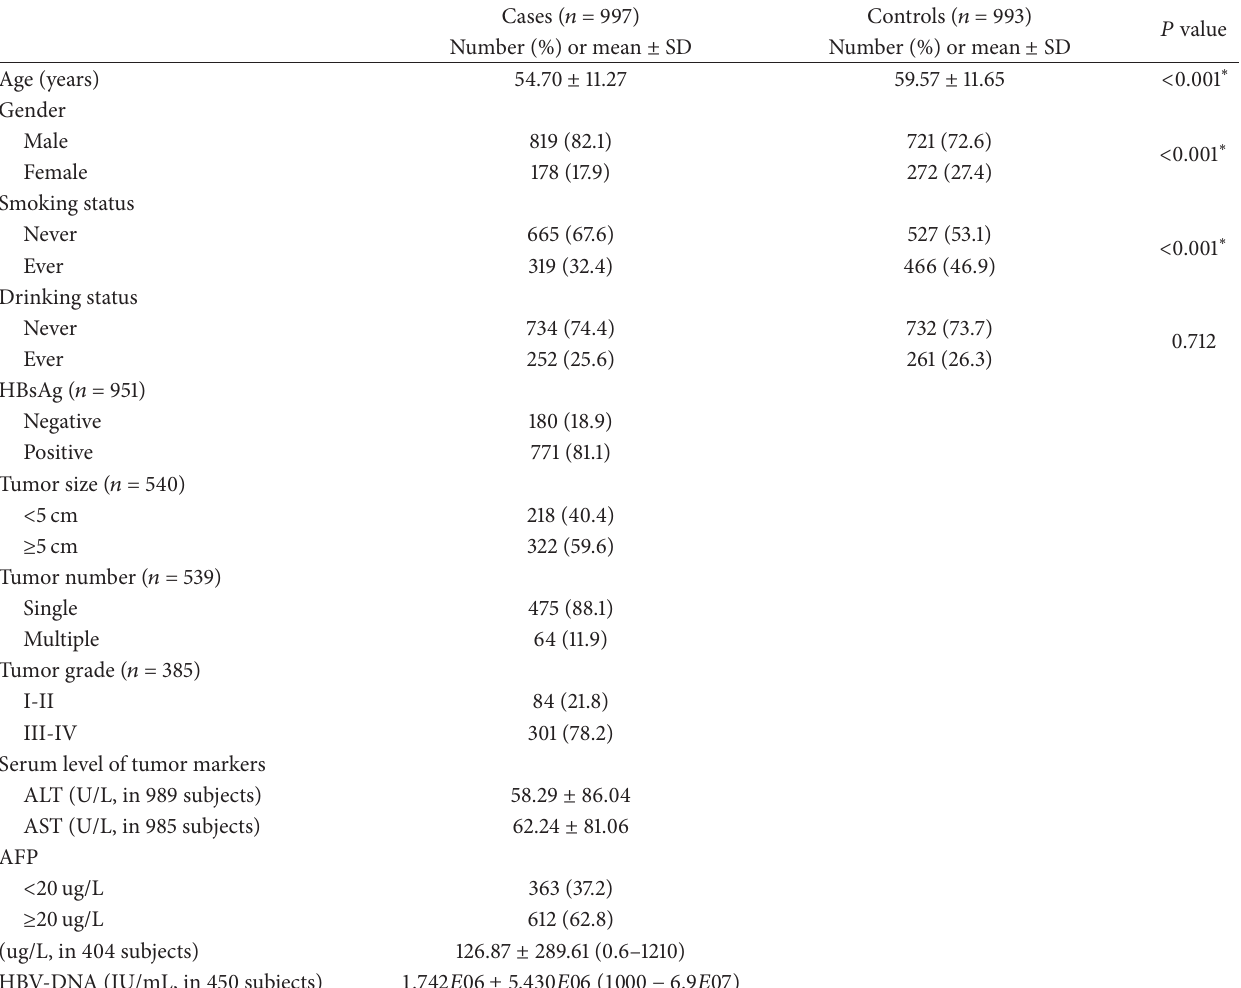
Table 1: General characteristics in hepatocellular carcinoma patients and controls.